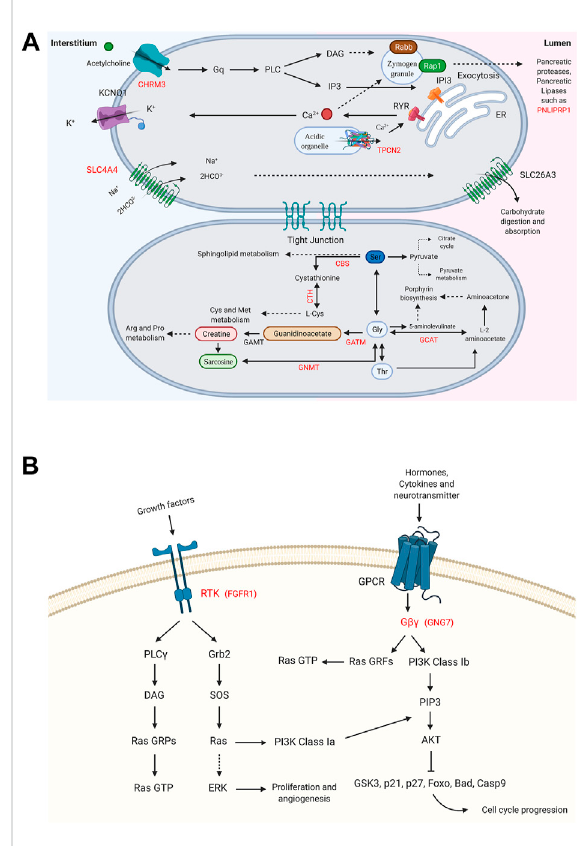
FIGURE 4 Enriched signaling pathwaysfor theDRGsinmaleandfemale pancreatic cancer (PC) patients. (A) Glycine, serine, and threonine metabolism_hsa00260 and pancreatic secretion_hsa04972 pathways are shown for DRGs in male PC patients. (B) Ras signaling pathway_hsa04014 and PI3K-Akt signaling pathway_hsa04151 are speci fi ed for FGFR1 and GNG7, the DRGs in female PC patients. ( p -value ≤ 0.05). “ Created with BioRender.com.